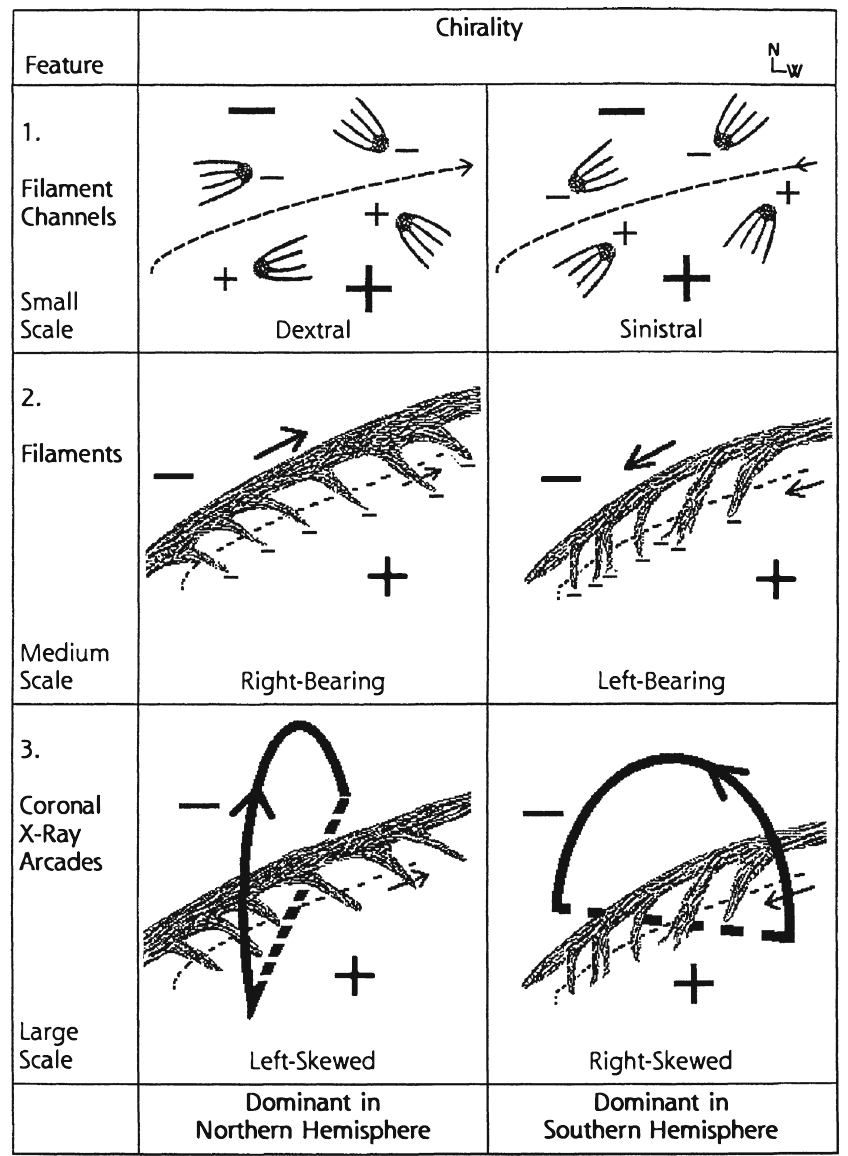
Fig. 7 Chirality relations between prominence(filament) and surrounding environment. 1 Chromospheric fibrils observed in filament channels; 2 filament extensions (barbs) from central spine; and 3 overlying coronal loops. Note this is the classic sketch from Martin (1998b), copyright by ASP—for an updated sketch see Fig. 7 of Martin (2015). This recent review emphasizes that proper chirality determinations require adequate spatial resolution and/or flow patterns to aid in seeing the direction of filament threads, as well as consideration of the perspective from which a filament is